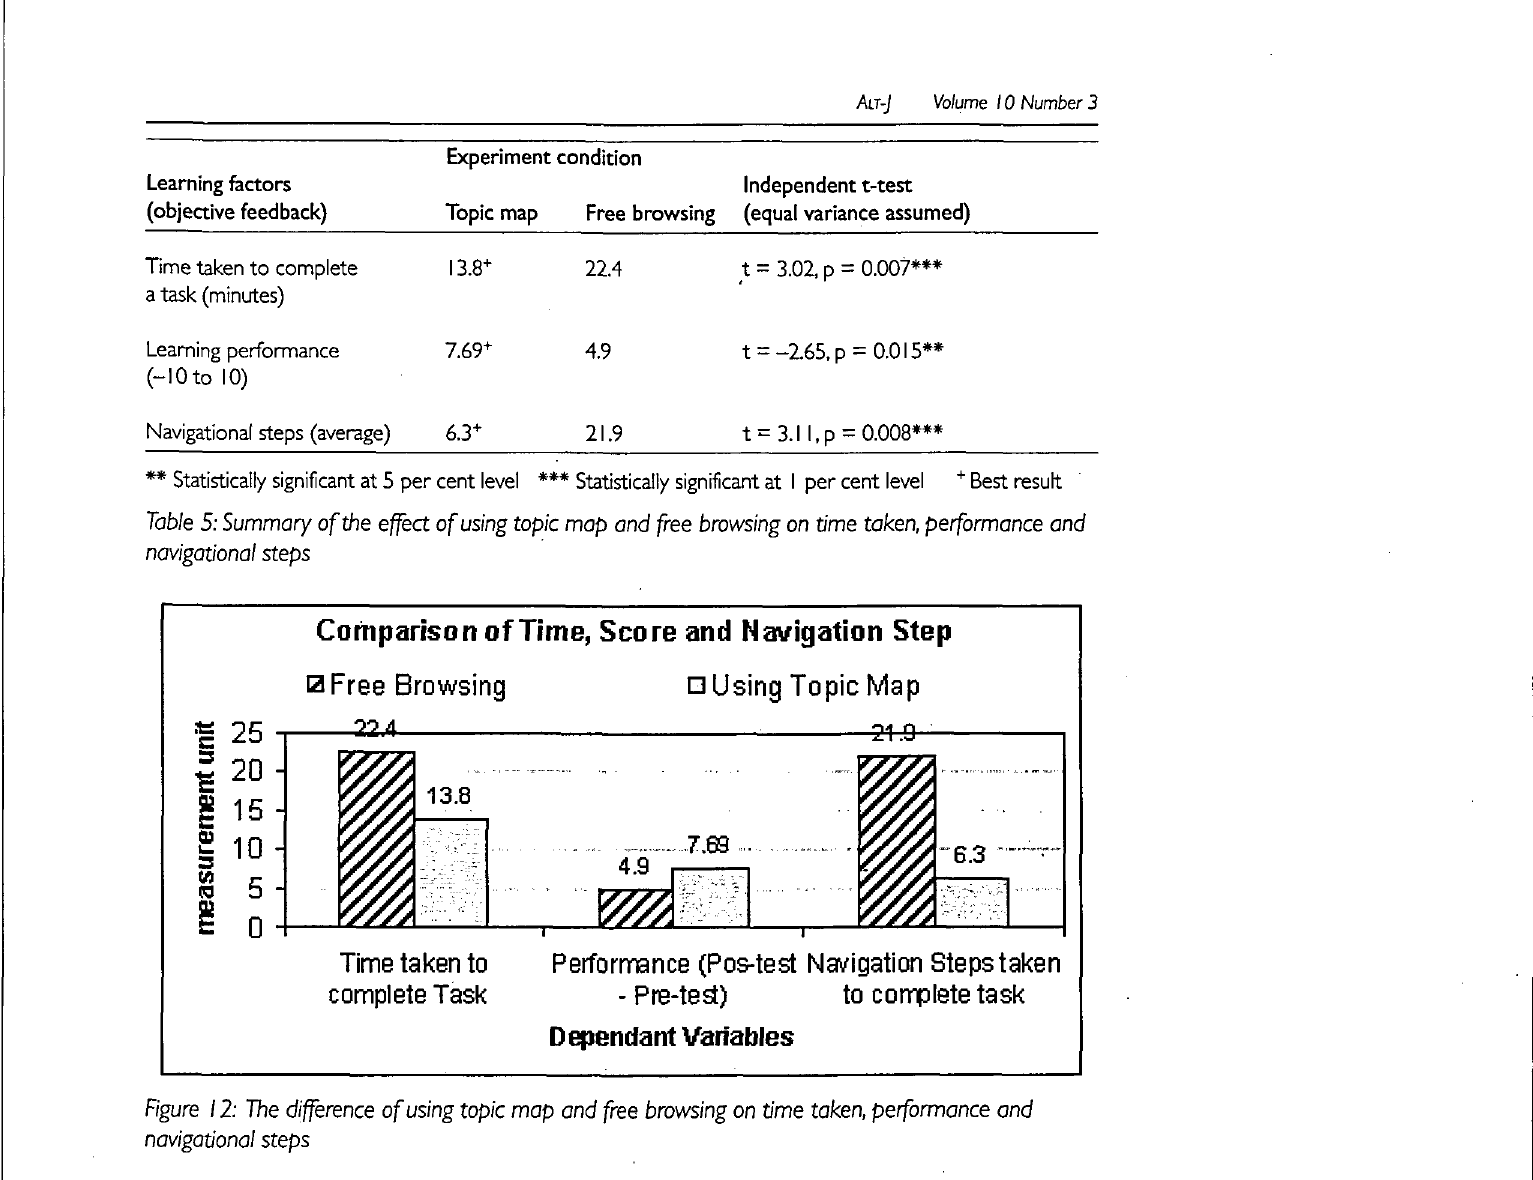
Figure 12: The difference of using topic map and free browsing on time taken, performance and navigational